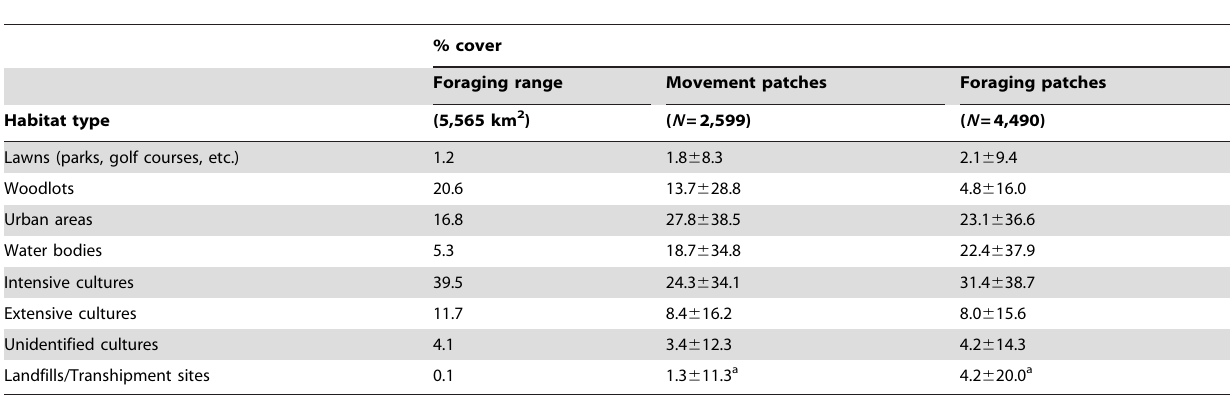
Table 1. Cover percentage of eight habitat types available in the foraging range of 109 Ring-billed gulls breeding on Deslauriers Island established as the minimum convex polygon calculated with all gull locations and mean cover percentage ( 6 1 SD) in